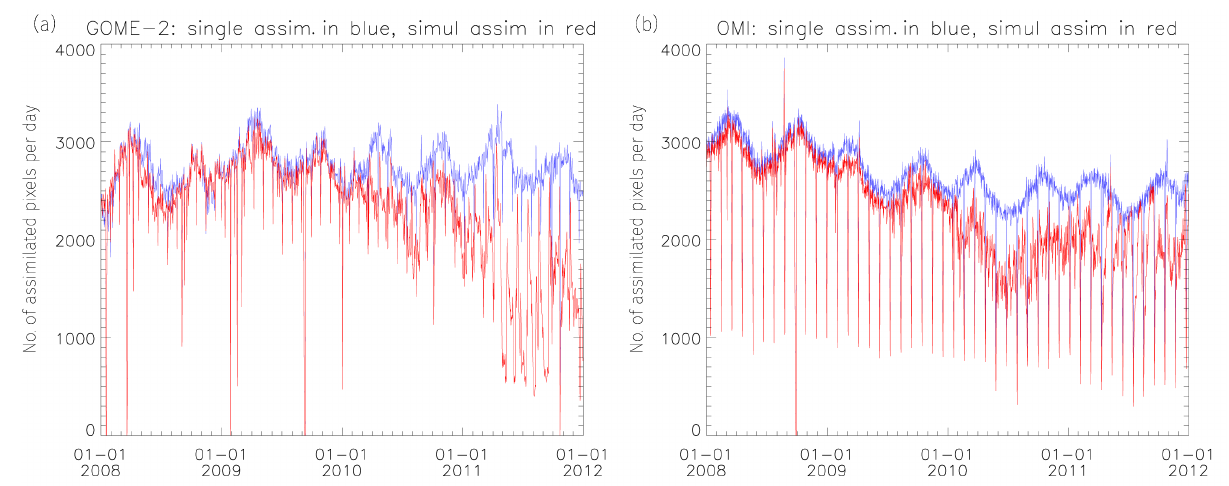
Figure 10. Number of assimilated observations from GOME-2 (a) and OMI (b) . The blue lines represent the single instrument assimilation, the red lines the simultaneous assimilation.